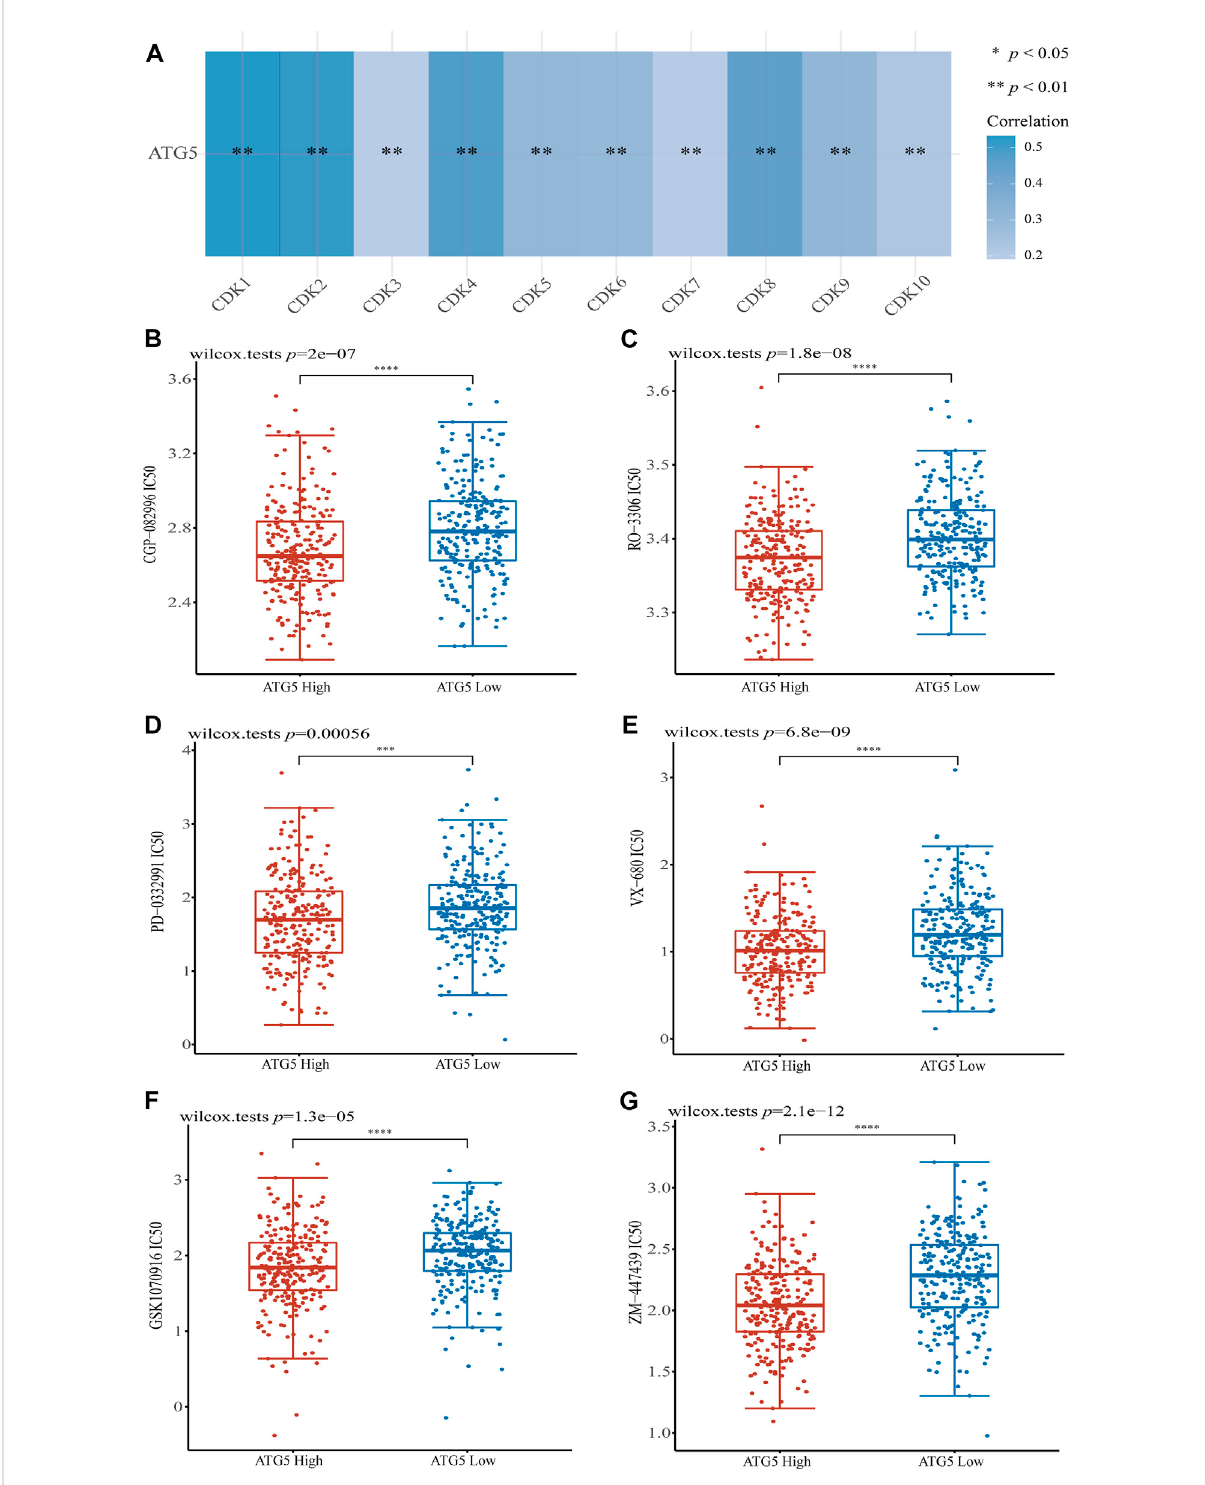
FIGURE 7 The correlations between ATG5 and G2M checkpoint. (A) The correlation of ATG5 and CDK family genes in TCGA HNSCC dataset. G2M checkpointinhibitors (B) CGP-082996, (C) RO-3306, (D) PD-0332991, (E) VX-680, (F) GSK1070916and (G) ZM-447439hadlowerIC 50 inATG5high expression HNSCC samples. * p < 0.05, ** p < 0.01, *** p <